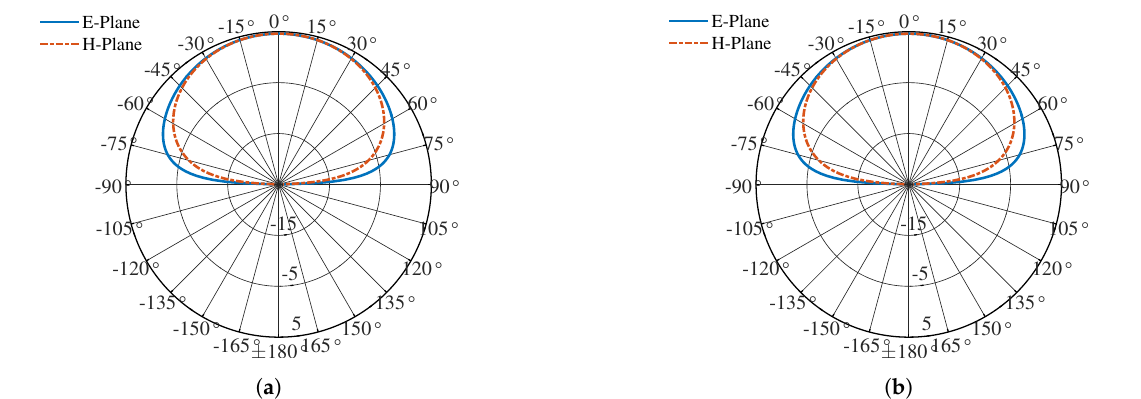
Figure 14. Simulated V-pol ( a ) and H-pol ( b ) radiation patterns at 24.25GHz.